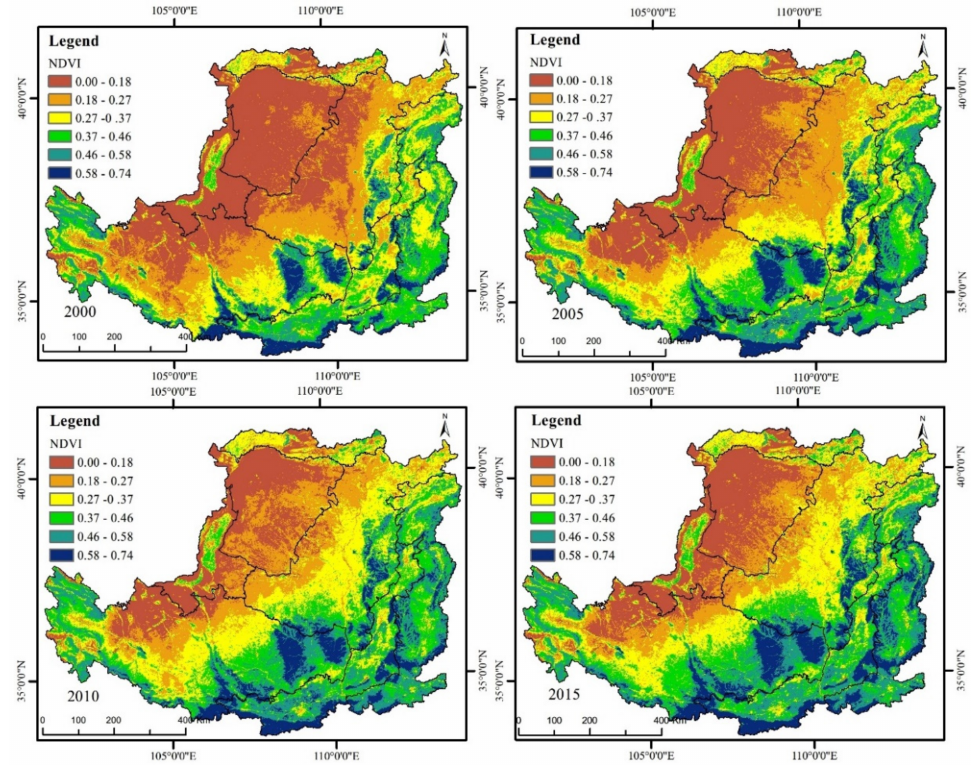
Figure 7. Spatial distribution of the NDVI on the Loess Plateau in different periods of ecological engineering.